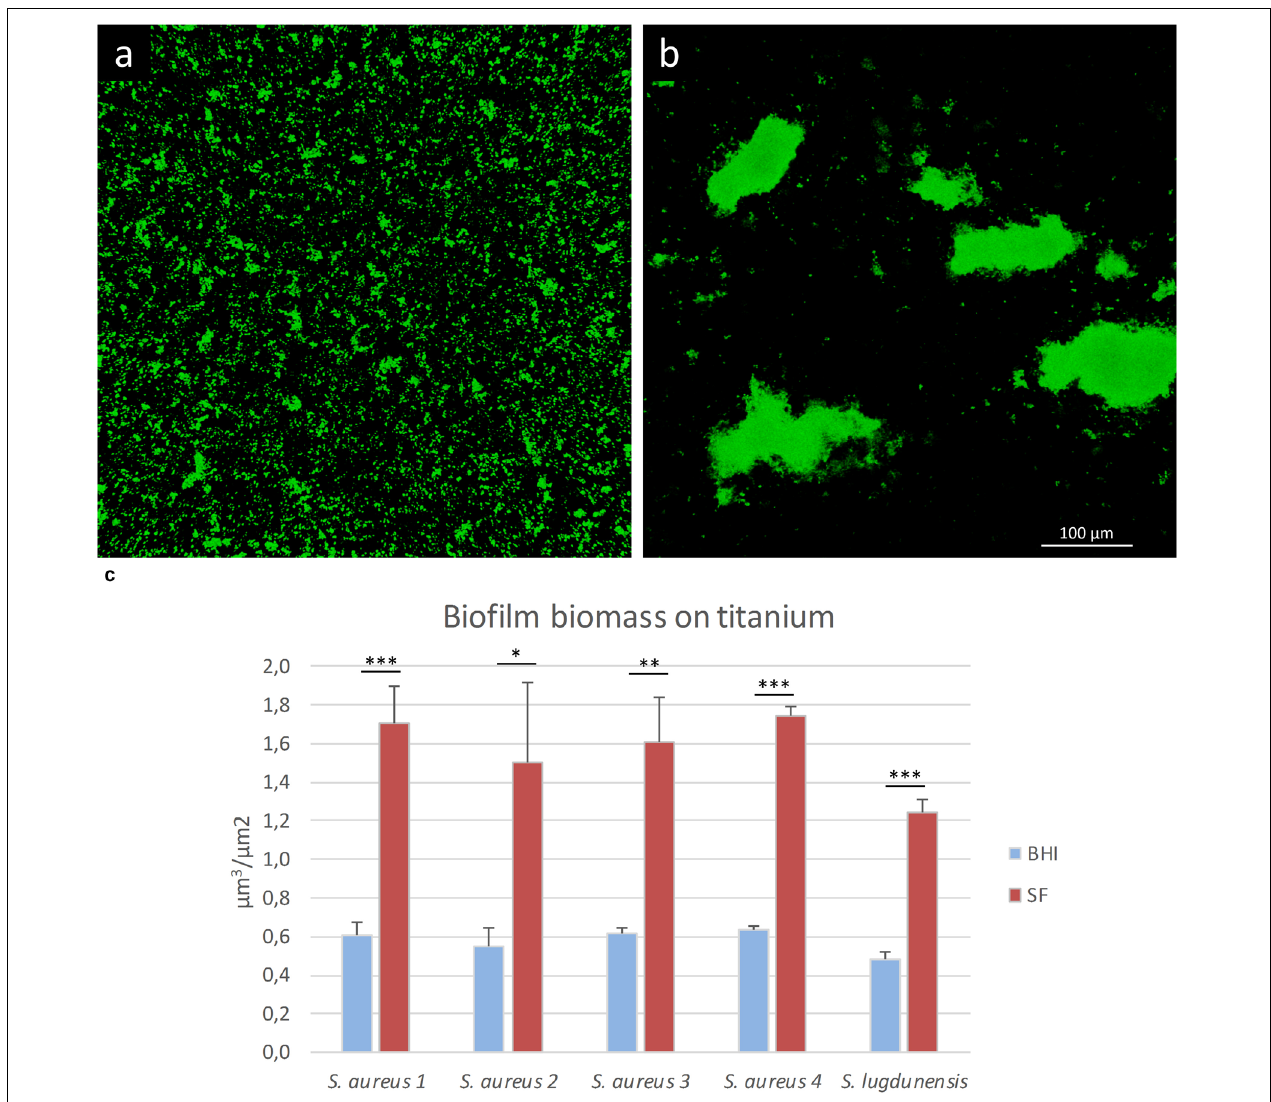
FIGURE 7 | Biofilm formation on titanium alloy in the presence of lab medium or synovial fluid (SF). In this figure, S. aureus 1 biofilm is grown in the presence of (a) BHI or (b) SF. (c) Biofilm volume/surface ratio of the staphylococcal strains grown in BHI (blue bars) or SF (red bars). The data reported are the average of three distinct acquisitions for each strain. * p < 0.05, ** p < 0.01, and *** p <